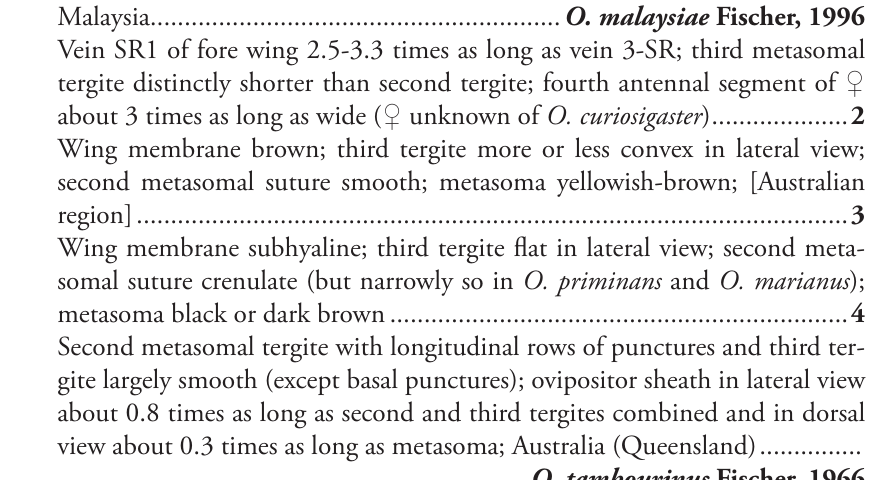
twice as long as wide; [ovipositor sheath about as long as first tergite]; East – Vein SR1 of fore wing 2.5-3.3 times as long as vein 3-SR; third metasomal tergite distinctly shorter than second tergite; fourth antennal segment of ♀ about 3 times as long as wide ( ♀ unknown of O. curiosigaster ) .................... 2 2 Wing membrane brown; third tergite more or less convex in lateral view; second metasomal suture smooth; metasoma yellowish-brown; [Australian region] ........................................................................................................ 3 – Wing membrane subhyaline; third tergite flat in lateral view; second meta- somal suture crenulate (but narrowly so in O. priminans and O. marianus ); metasoma black or dark brown ................................................................... 4 3 Second metasomal tergite with longitudinal rows of punctures and third ter- gite largely smooth (except basal punctures); ovipositor sheath in lateral view about 0.8 times as long as second and third tergites combined and in dorsal view about 0.3 times as long as metasoma; Australia (Queensland) ............... .................................................................... O. tambourinus Fischer, 1966 – Second tergite with longitudinal striae and third tergite entirely punctulate; ovipositor sheath in lateral view about as long as second and third tergites combined and in dorsal view about 0.5 times as long as metasoma; Papua 4 Notauli completely impressed and smooth; vein 1r-m of hind wing about as long as vein cu-a; medio-posterior depression of mesoscutum minute; [malar space about as long as basal width of mandible and without malar suture]; East Malaysia ................................................... O. priminans Fischer, 1996 – Notauli largely absent (except anteriorly); vein 1r-m of hind wing 1.5–2.0 times as long as vein cu-a; medio-posterior depression of mesoscutum large droplet-shaped or elliptical, but small in O. marianus ................................. 5 5 Vein 3-SR of fore wing about as long as vein 2-SR; malar space about 1.7 times as long as basal width of mandible; mesoscutum punctulate; apical seg- ments of antenna of ♀ (but ♀ unknown of O. curiosigaster ) blackish or dark brown as other segments; [medio-posterior depression of mesoscutum large droplet-shaped; crenulate second metasomal suture moderately wide and parallel-sided medially] ............................................................................... 6 – Vein 3-SR of fore wing 1.6–2.0 times as long as vein 2-SR; malar space about as long as basal width of mandible; mesoscutum smooth; apical segments of antenna of ♀ white or yellow ...................................................................... 7 6 Second metasomal tergite without rows of punctures between longitudinal striae and third tergite only with some superficial striae (Fig. 24); mesosoma brownish-yellow; dorsal carina of first tergite remain separated subbasally (Fig. 24); malar space about 1.8 times as long as basal width of mandible and head more elongate in anterior view (Fig. 16); hind basitarsus about 5.0 times as long as wide (Fig. 14); transverse carina of propodeum near